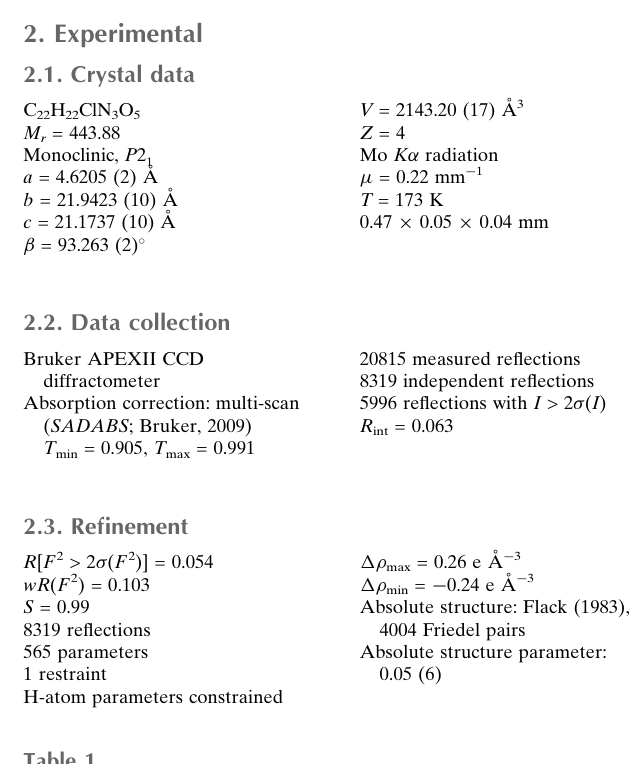
Hydrogen-bond geometry (A˚ , (cid:2)